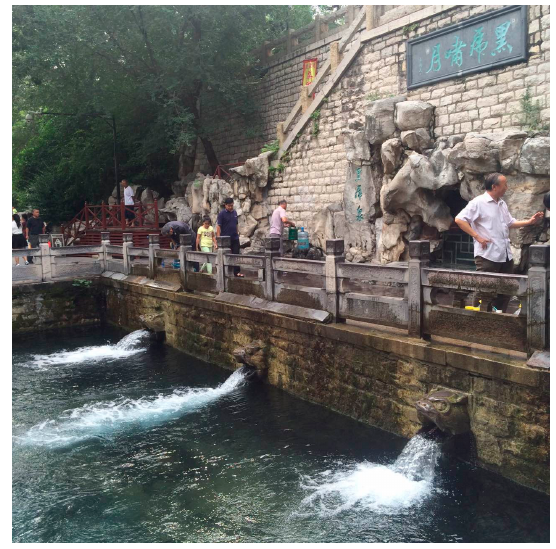
Figure 19. Heihu Spring in Jinan City.